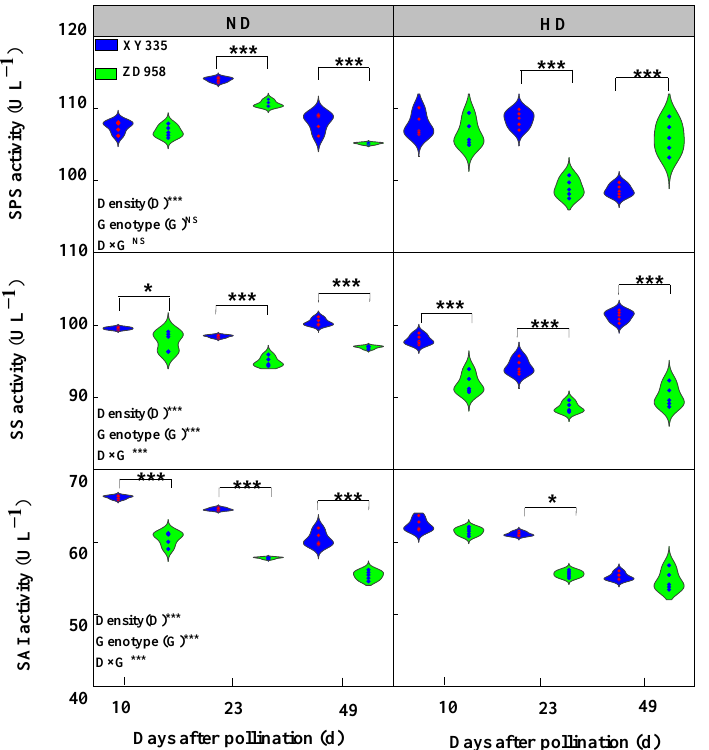
Figure 4. Dynamics of SPS, SS, and SAI activities in grain of two maize hybrids grown in 2018 under ND and HD treatments. SPS, Sucrose-phosphorus synthase; SS, Source synthase; SAI, Soluble acid invertase. Bars denote standard error ( n = 3). ND and HD indicate 60,000 and 90,000 plants ha − 1 density, *, ** and *** indicate significant difference at p < 0.05, p < 0.01, p < 0.001, and NS, no signifi- cance, respectively.